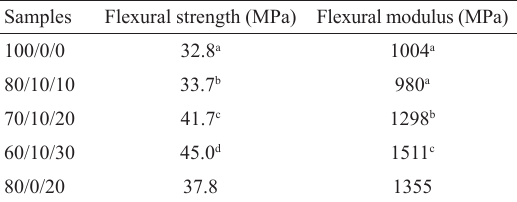
Figure 5: HDT obtained for the studied formulations. Table 3: Flexural strength and Flexural modulus of the formulations Samples